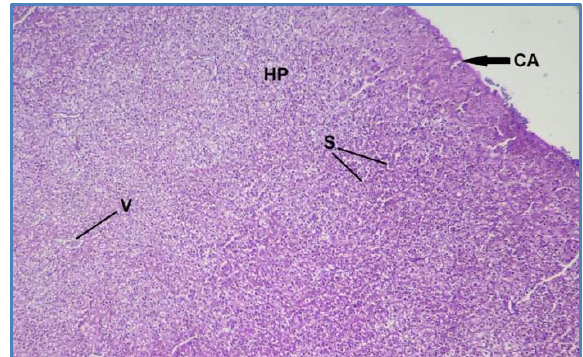
Figure, 6: Histological section of the liver in white-eared bulbul shows, the capsule (CA), hepatocyte (H), sinusoids (S), vein (V) hepatic plates (HP) (H and E 20X).